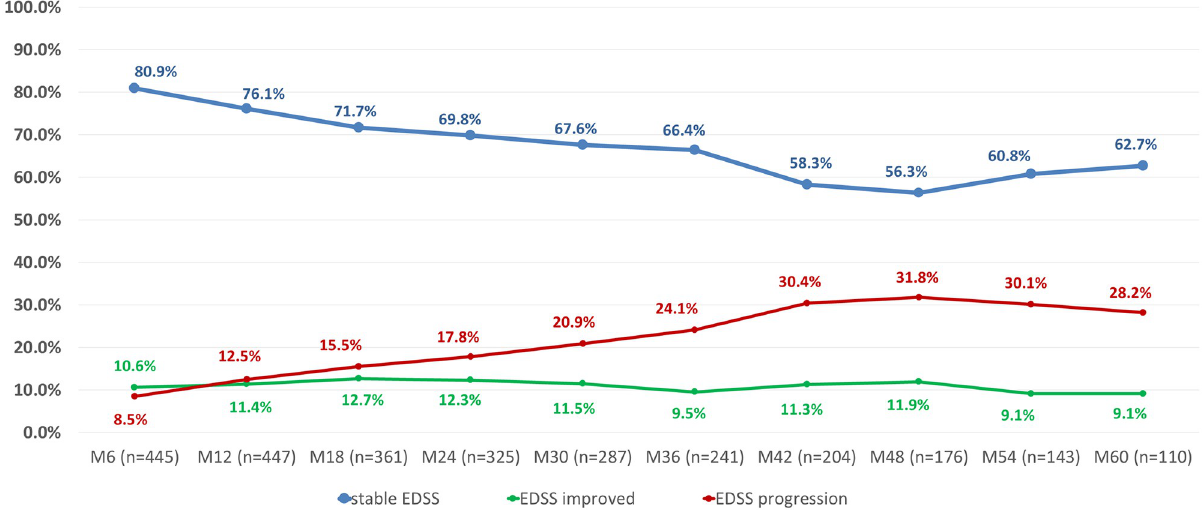
Fig 3. The proportion of patients with stable, improving and worsening EDSS scores.